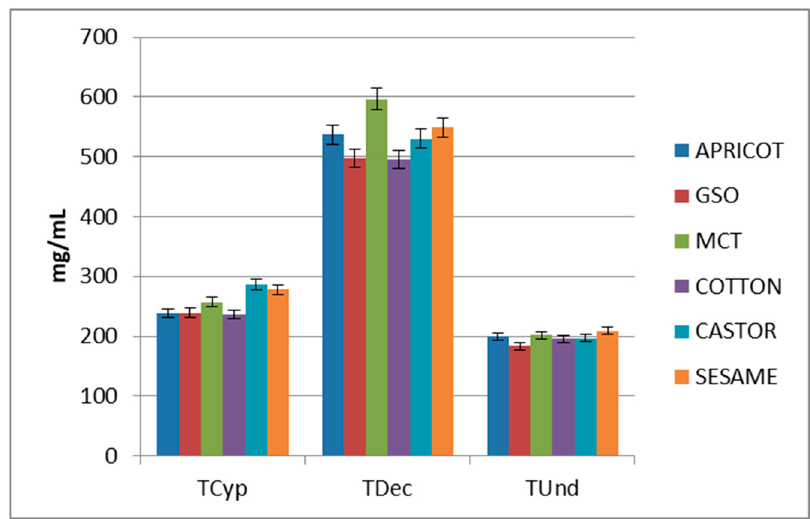
Figure 6. Graphical representations of esters solubility (standard deviation is represented by error bars) .